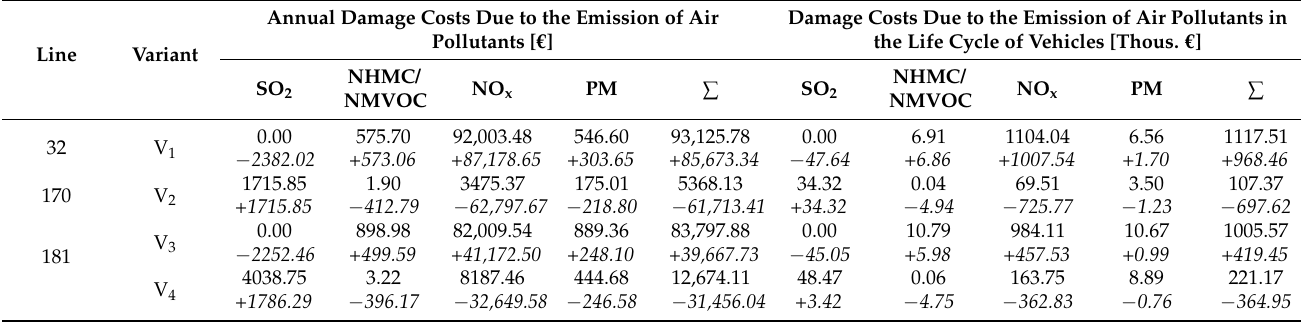
Table 3. Simulations of the damage costs due to the emission of air pollutants from public transport on the analysed lines in various variants and their comparison with the costs generated in the current